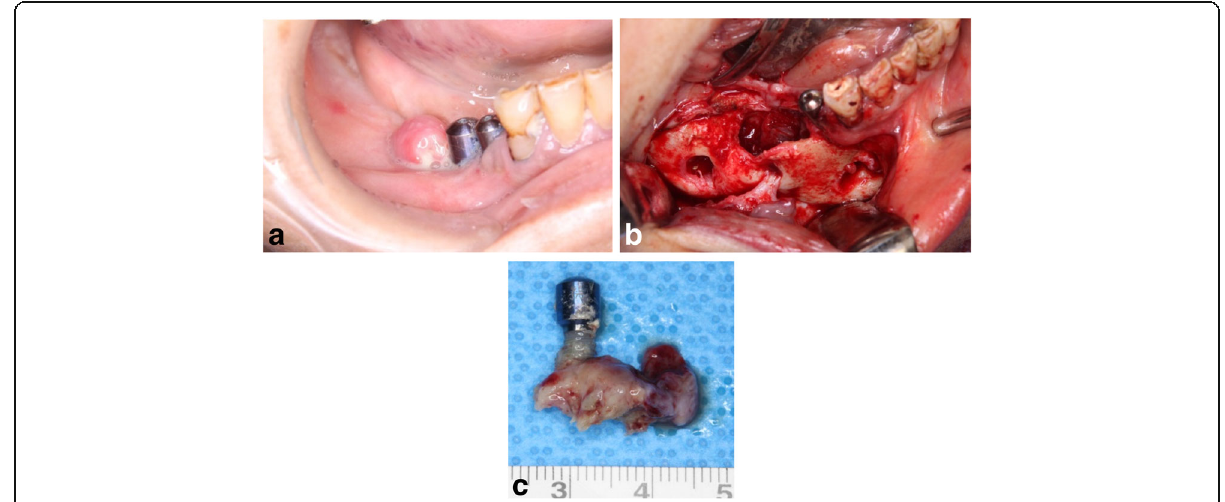
Fig. 4 a Preoperative intraoral photograph. b Intraoperative photograph of the sequestrectomy. c Removal of the dental implant with a specimen of the necrotic bone